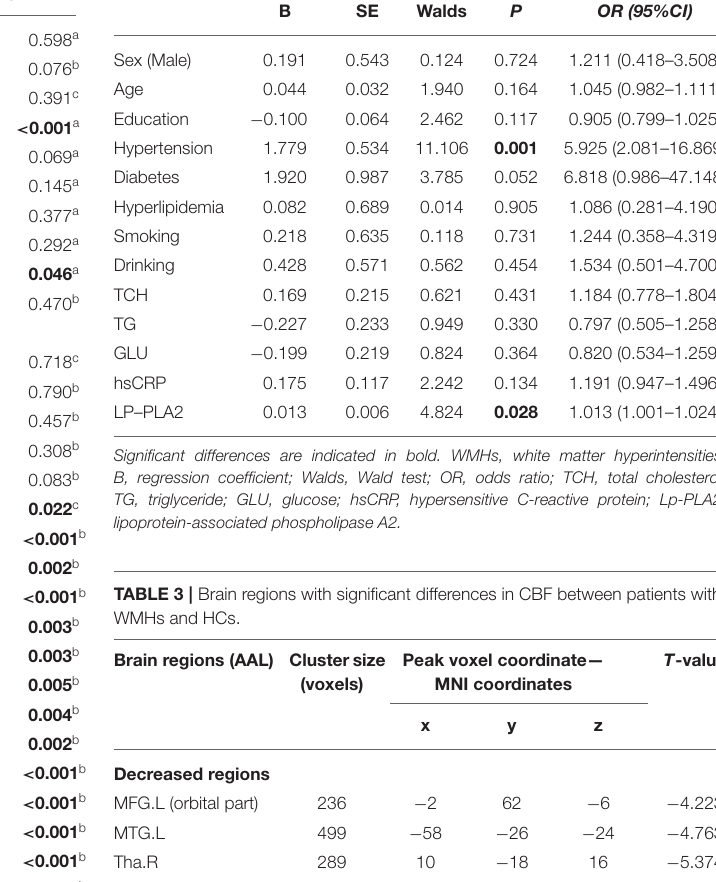
TABLE 1 | Demographic, clinical, and neuroimaging manifestations data. HCs ( n = 65) patients with WMHs ( n = 65) P Value